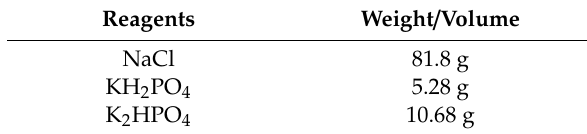
Table 1. Reagents for 10 × PBS (Phosphate Bu ff er Saline) bu ff er